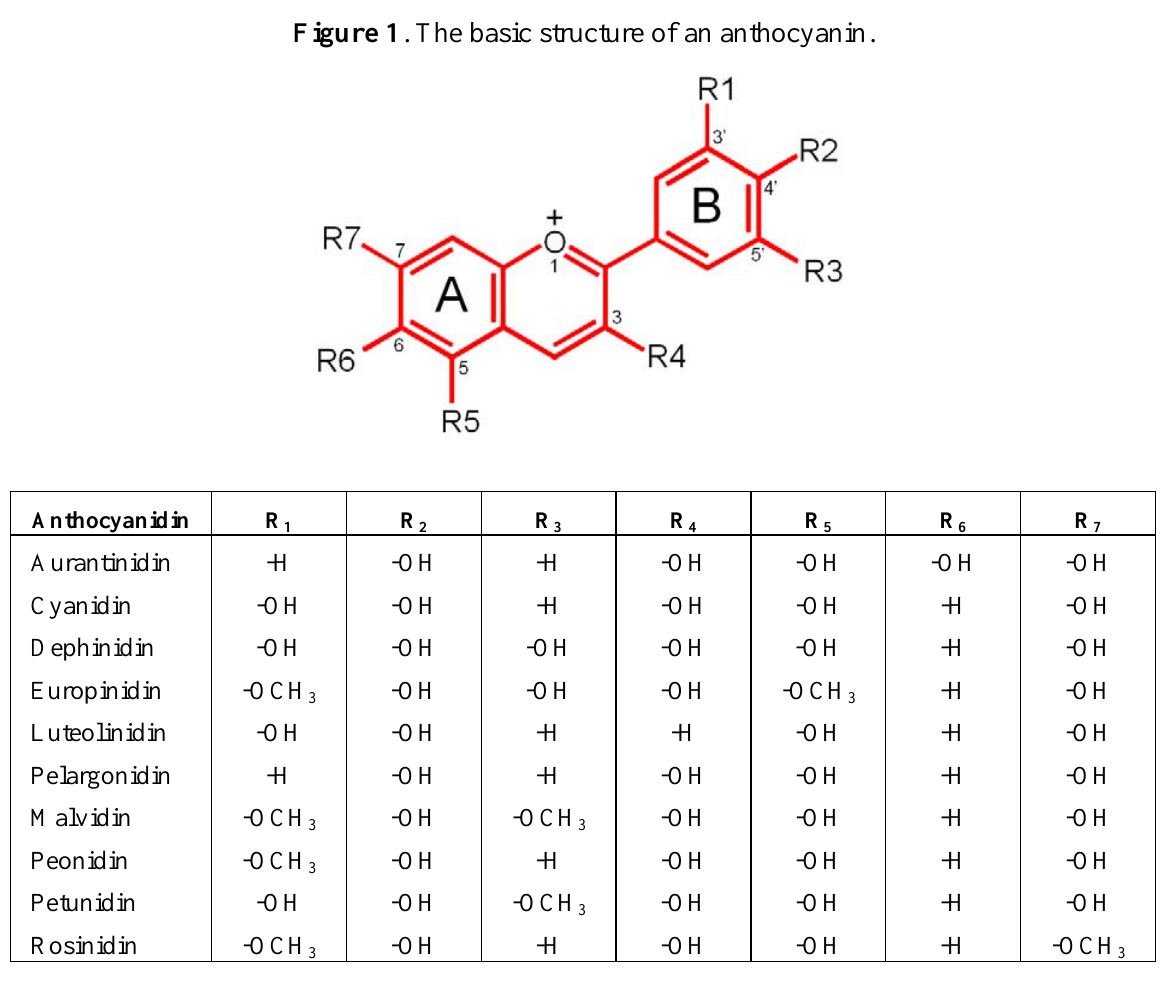
Figure 1 . The basic structure of an